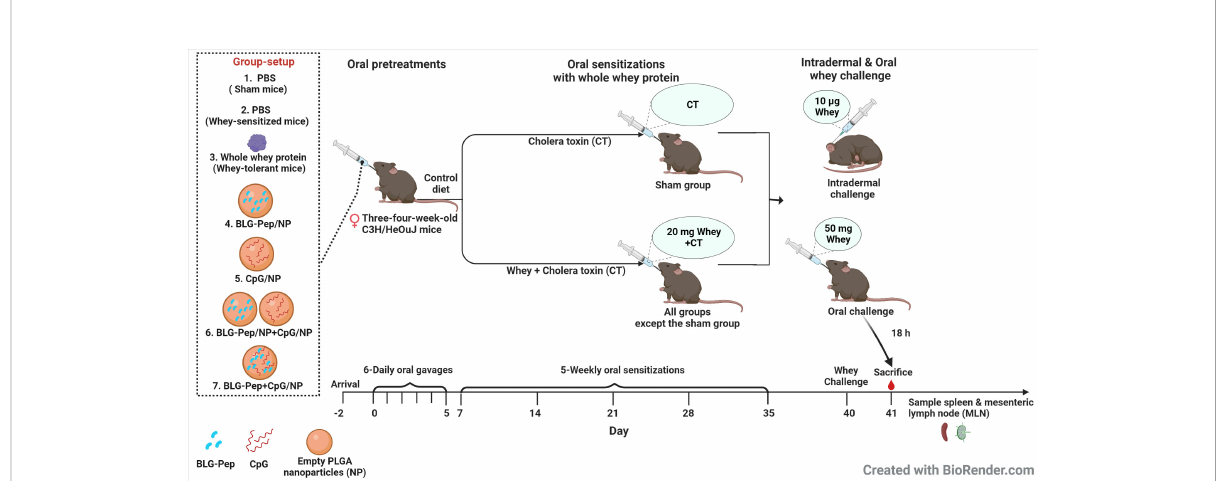
FIGURE 1 Experimental protocol for pre-treatment, sensitizations and challenge in murine model of cow ’ s milk allergy for the animal study. Three-four- week-old pathogen free female C3H/HeOuJ mice were given 6 daily oral pretreatments starting 2 days after arrival of the mice. Two days after the tolerance induction phase mice received 5-consecutive-weekly sensitizations with 20 mg whey plus 10 µg cholera toxin in 0.5 mL PBS for all groups but sham (only cholera toxin) from day 7 to day 35 to break whey tolerance. Five days after the last whey-sensitization, mice received intradermal challenge with 10 µg whole whey protein in the ears and at t=0 h and t=1 h the acute allergic skin response (ear swelling) was determined. Three hours after the intradermal whey challenge, the mice were orally challenged by means of gavage with 50 mg whey in 0.5 mL PBS. Eighteen hours after the oral whey challenge, mice were anesthetized with iso fl urane and euthanized after blood sampling. Subsequently, spleen and mesenteric lymph nodes were collected immediately for further analysis. CT, Cholera toxin; NP,